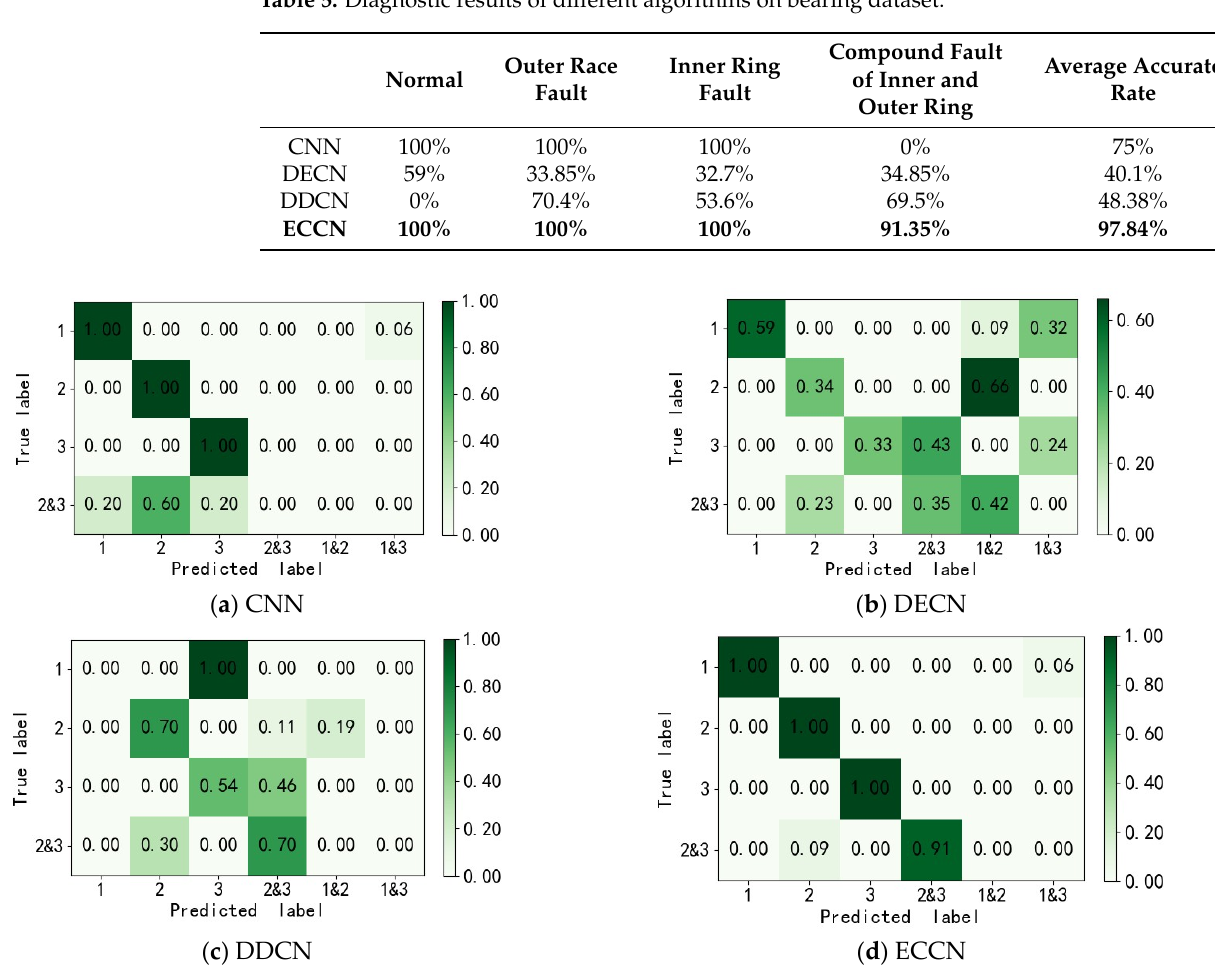
Table 5. Diagnostic results of different algorithms on bearing dataset.